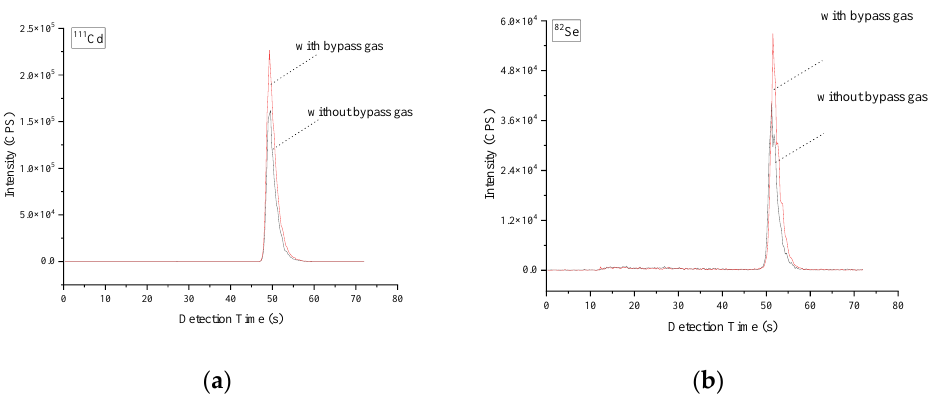
Figure 2. The effect of the gas line design with or without bypass gas on ICP-MS signals of Cd and Se. The other operating parameters are consistent with Table 3. A rice sample (Cd = 19 ± 1 ng·g −1 and Se = 36 ± 2 ng·g −1 ) was employed for slurry sampling. ( a ) Cd signal peak with or without bypass gas. ( b ) Se signal peak with or without bypass gas.